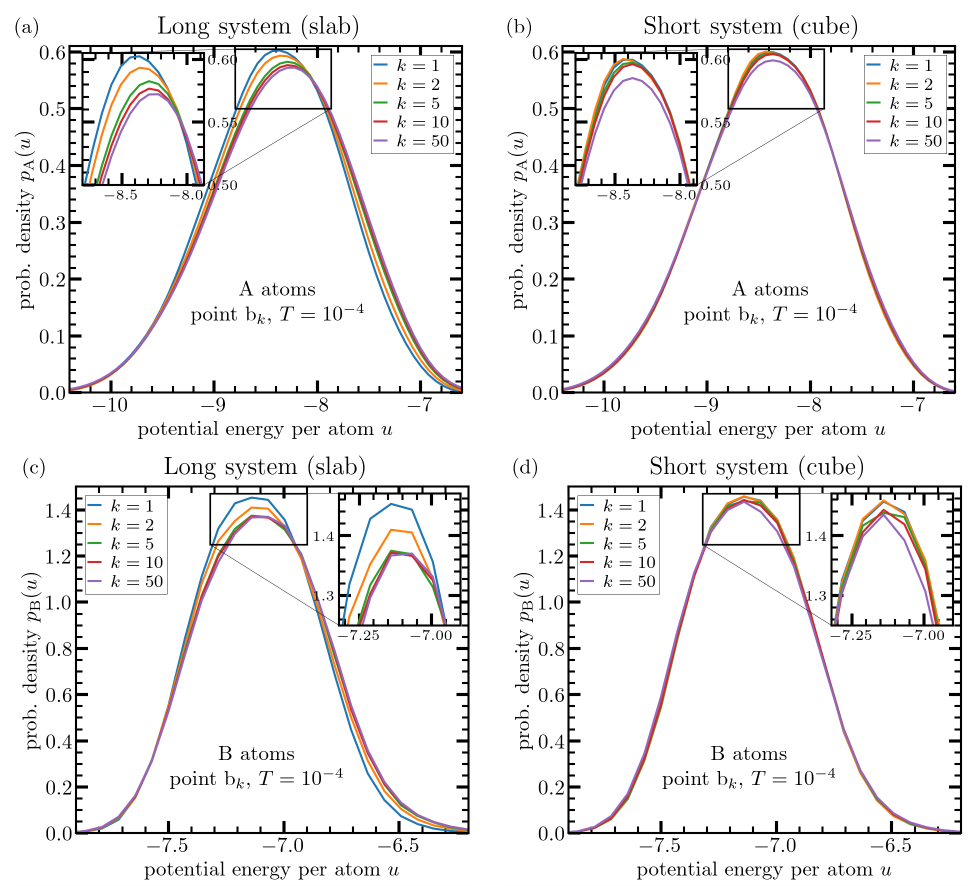
Figure 6. Similar type of analysis as in Figure 4 evaluated at point b k , i.e., at the cryogenic temperature, where the system structure is essentially frozen due to the lack of kinetic energy. Upper panels show p α ( u ) as obtained after applying different numbers of thermal cycles as indicated in the legends for A-atoms in the case of of the slab ( a ) and cube ( b ) geometry. Panels ( c , d ) show similar data for the case of B-atoms. In this case, the crucial difference between long and short systems regarding the effects of deep thermal cycling is more